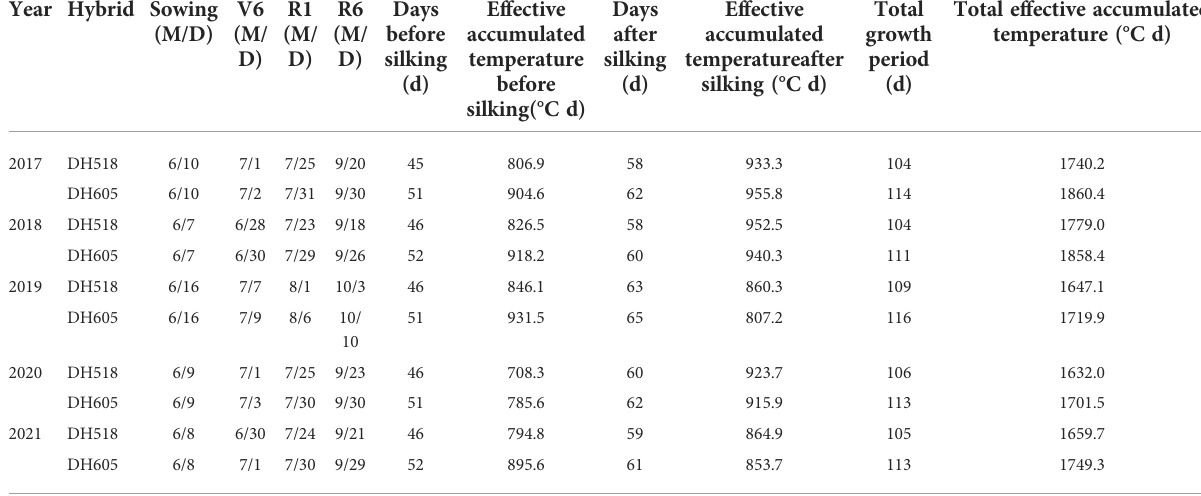
TABLE 2 Growth process and effective accumulated temperature of summer maize hybrids with different growth duration from 2017 to 2021. Year Hybrid Sowing V6 (M/D)